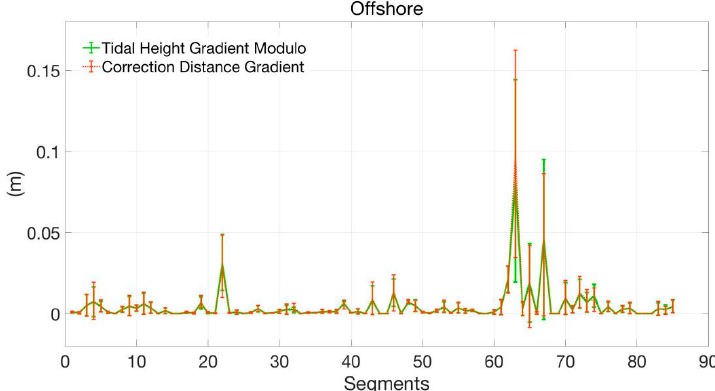
Figure 6. Tidal height gradient modulos and the corresponding tidal positioning correction gradient modulos of the offshore segments.